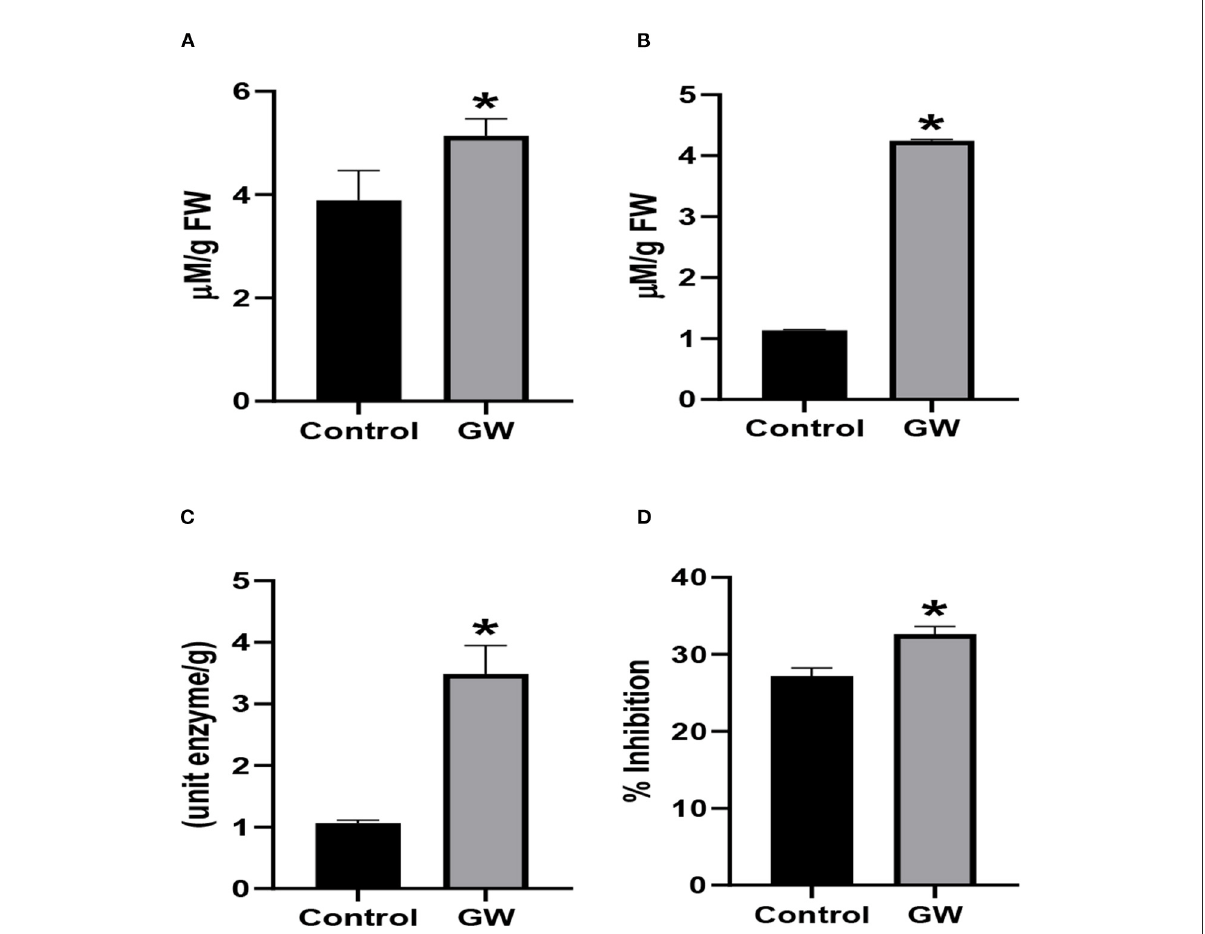
FIGURE12 Effect of Fusarium oxysporum GW on the activities of antioxidant enzymes (A) catalase, (B) AAO, (C) peroxidase, and (D) percent inhibition of DPPH (ROS scavenging activity) in wheat seedlings. Assays were performed on the leaf extract of wheat seedlings grown for 21 days under control conditions. Bars labeled with * are significantly higher ( t -test; p <